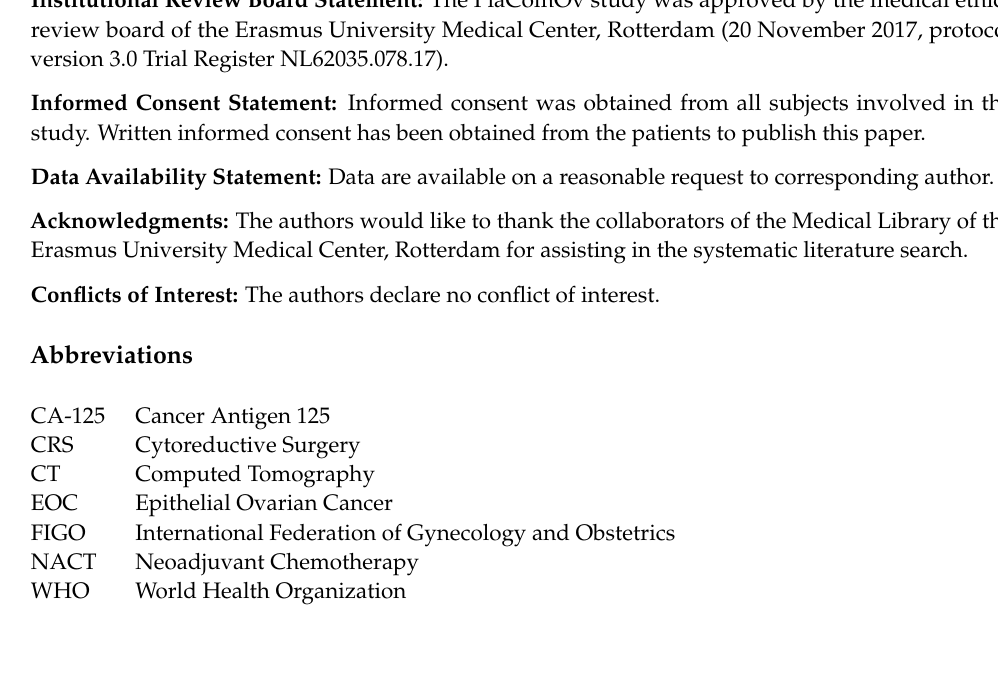
Table S2: Detailed methods of each platform used to analyze CA-125, Table S3: Univariable anal- ysis of factors predicting normal levels of preoperative CA-125 in primary CRS, Table S4: Uni- variable analysis of factors predicting normalized preoperative CA-125 level before interval CRS, Table S5: Univariable analysis of factors predicting >95% reduction in CA-125 after NACT. Table S6: Univariable analysis of factors predicting >95% reduction in CA-125 after NAC. Figure S1: cross-validated ROC-curve for primary CRS, Figure S2: cross-validated ROC-curve for interval